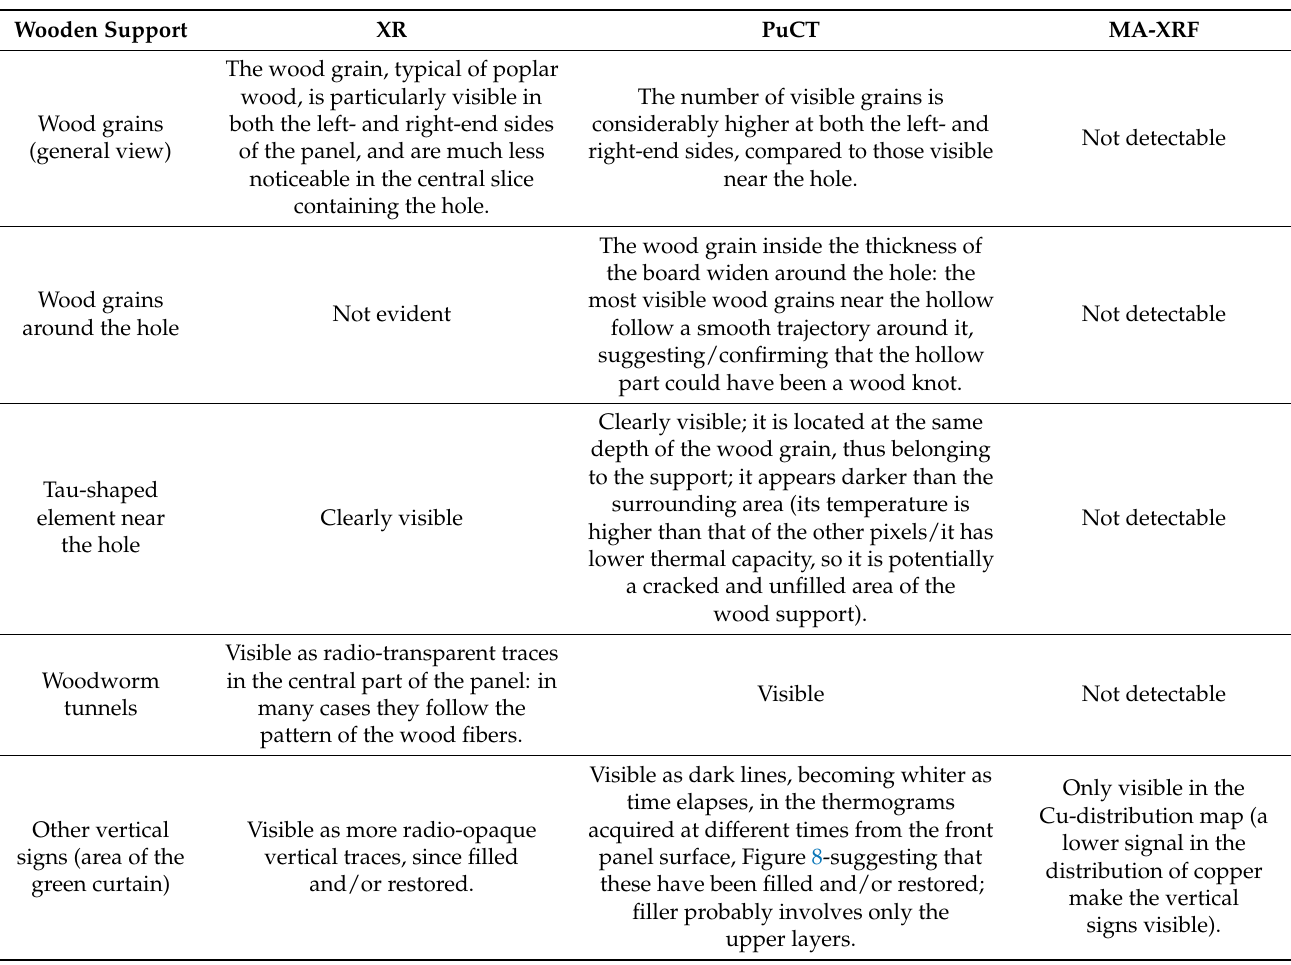
Table 1. Summary of the results from XR, PuCT, and MA-XRF analyses of the wooden support.